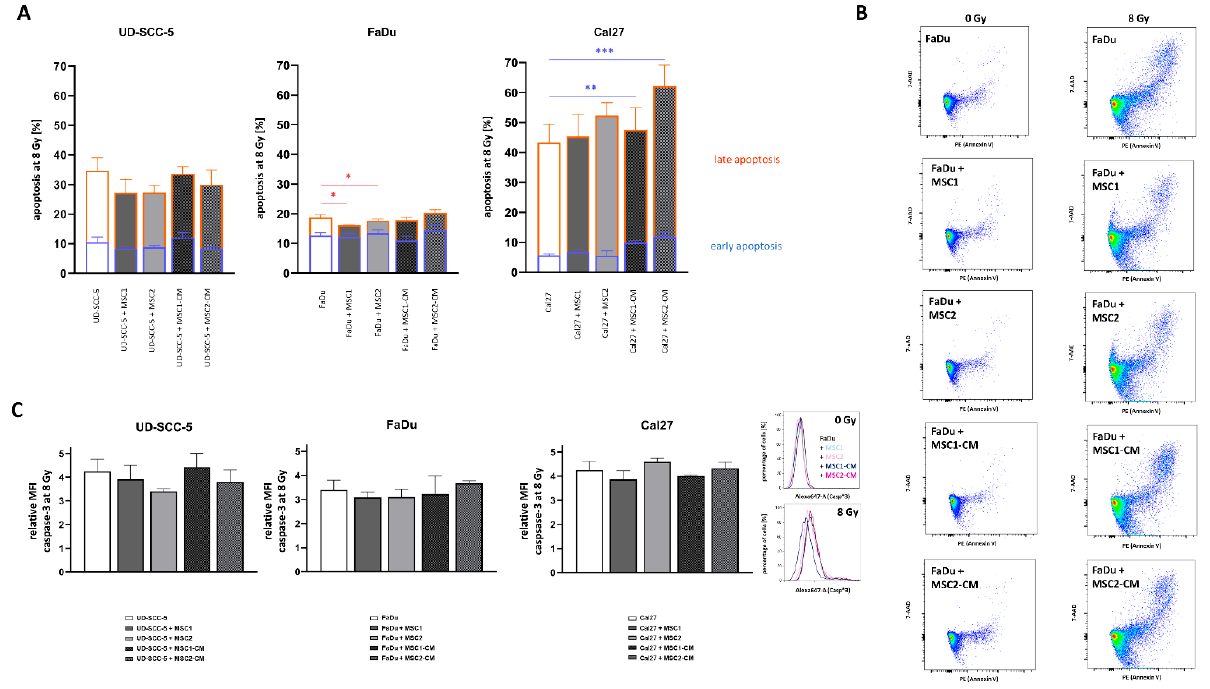
Figure 5. HNSCCs’ apoptosis rates after irradiation are unaltered after MSC co-culture. ( A ) Rates of irradiation-induced early (blue) and late (orange) apoptosis at 96 h in HNSCCs using annexin V/7-AAD stainings. ( B ) Representative flow cytometry plots of annexin V/7-AAD stainings in HNSCCs, either alone or co-cultured with MSCs or co-cultured in MSC-CM, after exposure to ionizing radiation. ( C ) Relative mean fluorescence intensity (MFI) of cleaved caspase-3 in irradiated HNSCCs depending on MSC co-culturing. Representative histograms show the fluorescence inten-